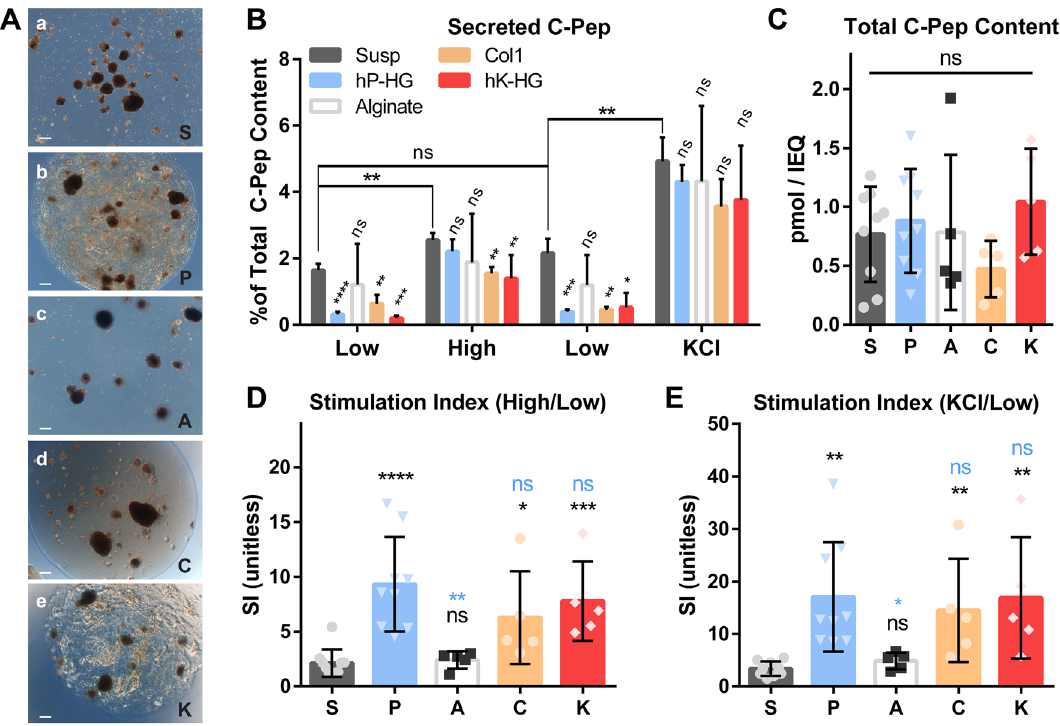
Figure 3. hP-HG co-culture improves islet function after 2 days of culture. (A) Representative phase contrast images of islets cultured in suspension (“S”) (a), hP-HG (“P”) (b), alginate (“A”) (c), Col1 (“C”) (d), or hK-HG (“K”) (e) were assessed for function on Day 2 of culture (scale = 200 microns). (B) A static glucose stimulated insulin secretion (GSIS) assay was performed using sequential low glucose (2.8 mM, “Low”), high glucose (28 mM, “High”), a return to low glucose, followed by low glucose + KCl (30 mM KCl, “KCl”); basal and stimulated C-peptide (C-pep) secreted during the static GSIS with human islets are shown as a percentage of total C-pep content. Statistics indicated above each bar are relative to the “S” control for the same treatment. (C) Total C-pep content of islets undergoing the indicated treatments. Stimulation index (D , high/low glucose) ( E , KCl/low glucose) of human islets cultured in all five conditions, determined by static GSIS. Statistical comparisons indicated in black are relative to “S”, and indicated in blue are relative to “P”. (S,P: n = 9; A,C,K: n = 5 islet donors) ( ns not significant, *p < 0.05, **p < 0.01, ***p < 0.001, ****p <